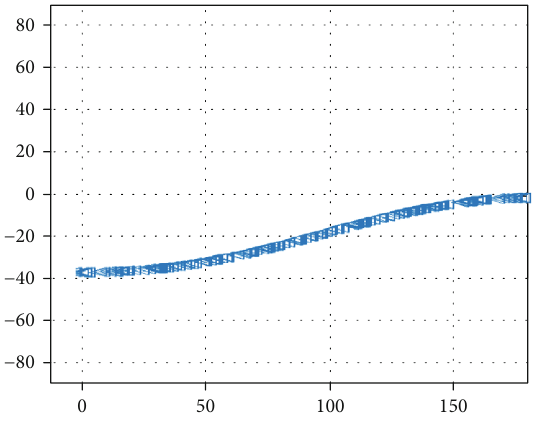
Figure 13: The computation time curve of the grey wolf optimizer.